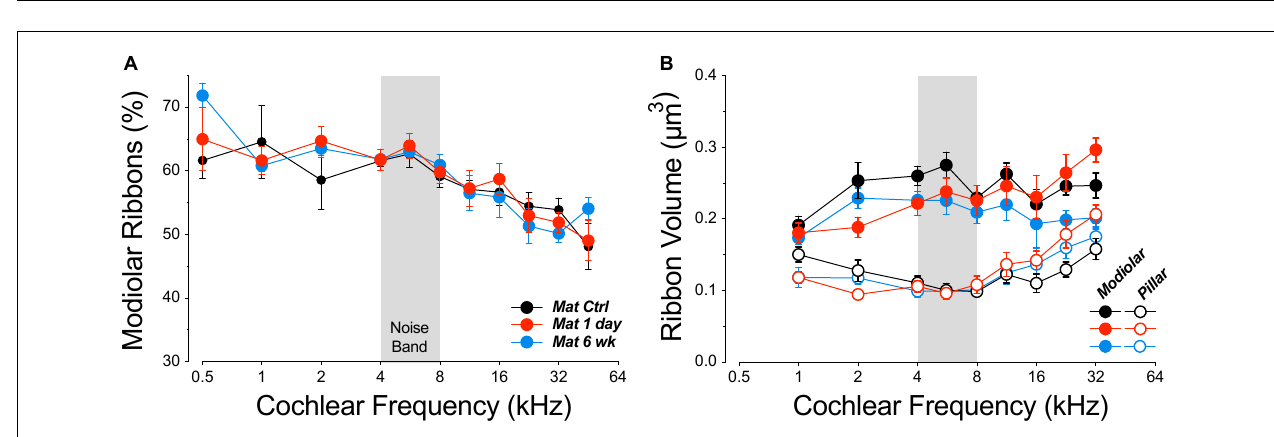
FIGURE 10 | The modiolar-pillar ratio of ribbon counts is unaffected by noise exposure (A) , but the ribbon gradient is reduced 6 weeks after noise exposure (B) . Data are means ( ± SEMs) as extracted from the following group sizes: control n = 7 ears of 4 animals, 1 day n = 8 ears of 5 animals, 6 weeks n = 4 ears of 2 animals.